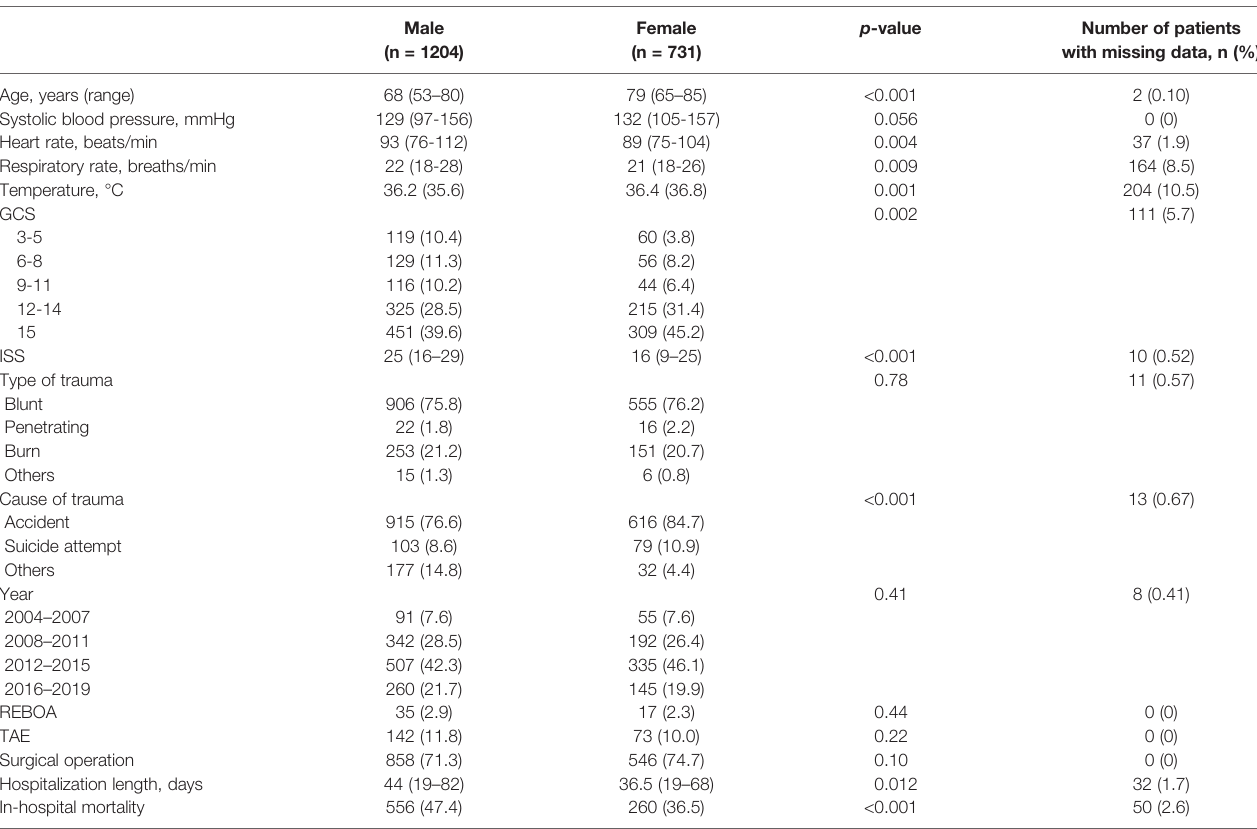
TABLE 1 | Baseline characteristics of eligible patients.